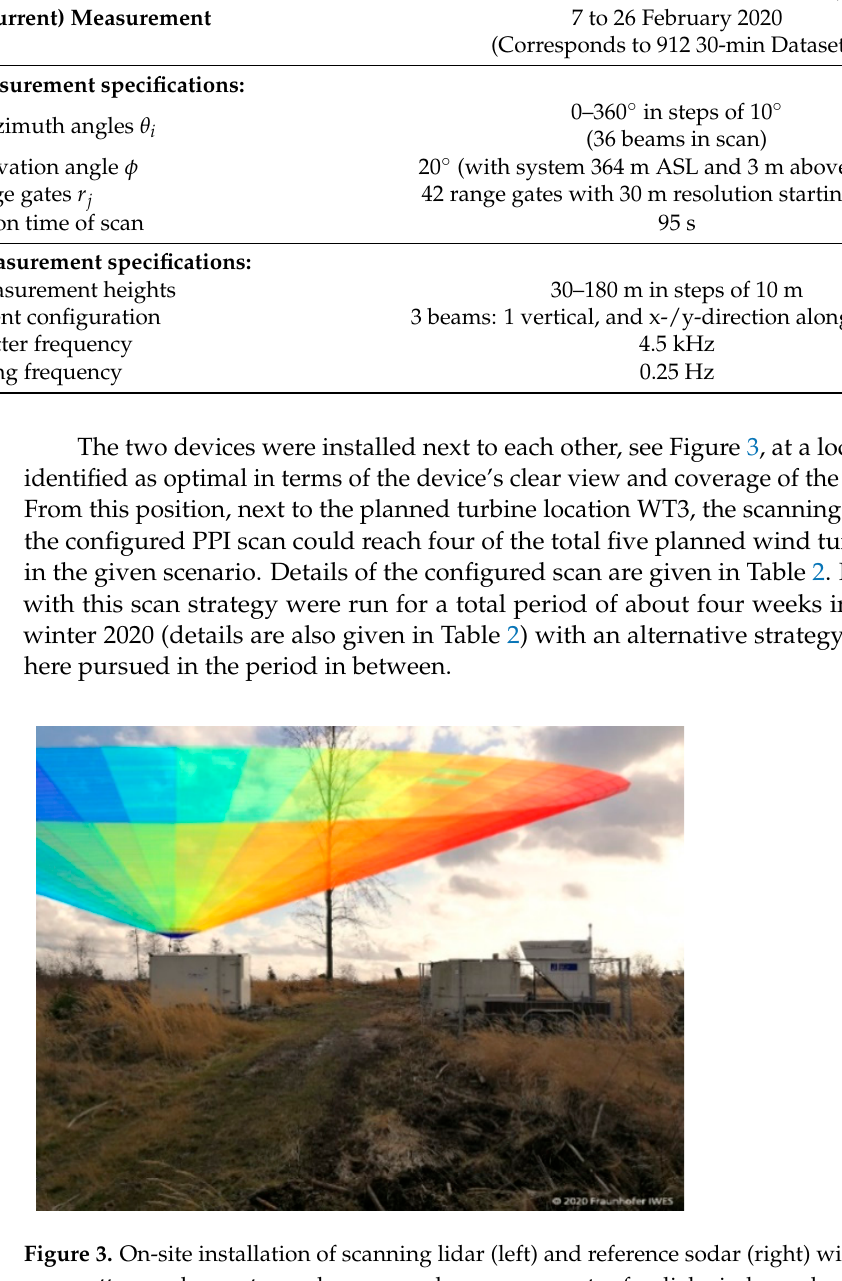
Period of (Concurrent) Measurement